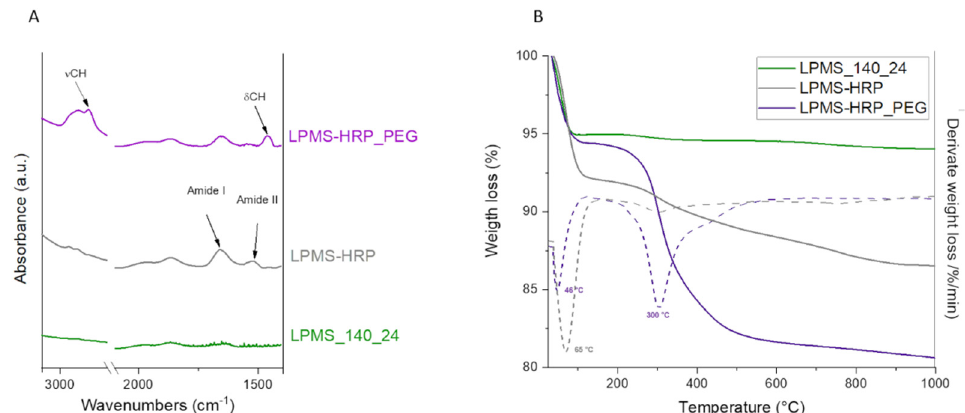
Figure 4. ATR-FTIR spectrum ( A ) and thermogravimetric analysis (TGA) curves ( B ) with relative derivative TGA curve (dotted line) of LPMS_140_24 (green), LPMS-HRP (grey), and LPMS-HRP_PEG (purple) particles.